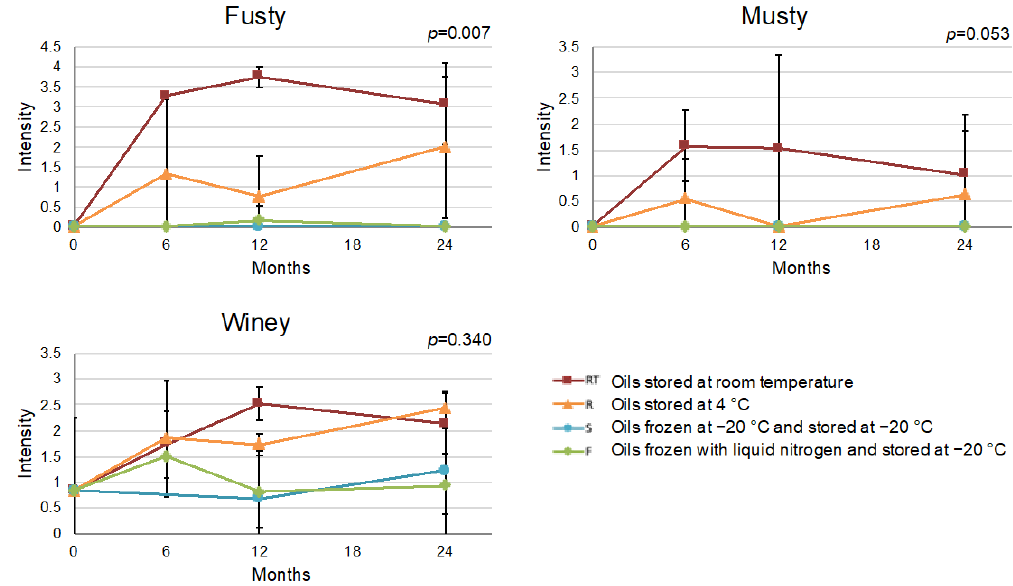
Figure 4. Interaction plot between storage conditions and time for the sensory defects fusty, musty and winey of the unfiltered oil (UO). p ≤ 0.05 indicates significant interaction between the two factors (storage conditions and storage time). Error bars correspond to the standard deviation.